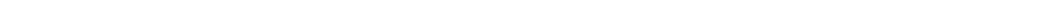
(see fi gure on previous page) Fig. 5 PL deacylation-acylation cycle imbalance causes TAG accumulation, protecting against α -syn overexpression. A Reduction of total lipid phosphorus in cells overexpressing α -syn was determined by the method of Rouser. B PL pro fi les (CL cardiolipin, PI phosphatidylinositol, PA phosphatidic acid, PC phosphatidylcholine, PE phosphatidylethanolamine, PS phosphatidylserine) of pcDNA and WT α -syn cells were analyzed by TLC separation followed by lipid phosphorus determination. C [ 3 H]-OA incorporation into PA and PC was detected in our model. D The effect of the activity of different PLA2 isoforms on cell viability was determined by the treatment with speci fi c inhibitors: BEL for iPLA2 inhibition, ATK for cPLA2 inhibition and YM for sPLA2 inhibition. E , F iPLA2 and cPLA2 activation role during α -syn overexpression was determined through SYTOX Green staining and the MTT reduction assay using the dual inhibitor PTK. DAPI was used as nuclear marker. G The involvement of α -syn-induced PLA2 activation in TAG accumulation was assessed by TAG measurement under iPLA2 and cPLA2 inhibition by PTK in pcDNA and WT α -syn neurons. The schematic view shows the action of PLA2 on PL hydrolysis at the sn-2 position and isoform-speci fi c inhibitors BEL, ATK and YM, and PTK, a dual inhibitor of iPLA2 and cPLA2. A – G Scale bars 20µm. All experiments were repeated three times. Bars represent means± standard deviation (SD, n = 3). * p < 0.05, ** p < 0.01, *** p < 0.001 vs. control.